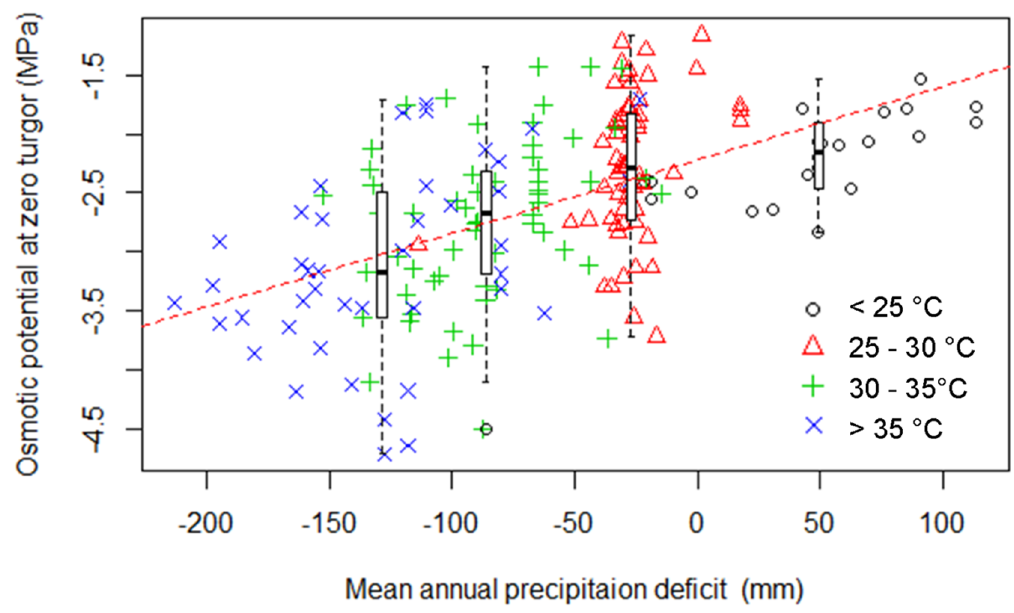
Figure 3. Relationship between mean annual precipitation deficit versus the osmotic potential at zero turgor ( R 2 = 0.30, p < 0.001). Data are binned by maximum temperature in hottest month (0.98 percentile) and box and whisker plots are drawn based on this binned data. Data are fitted with linear regression (red dashed line), see Table 1 for